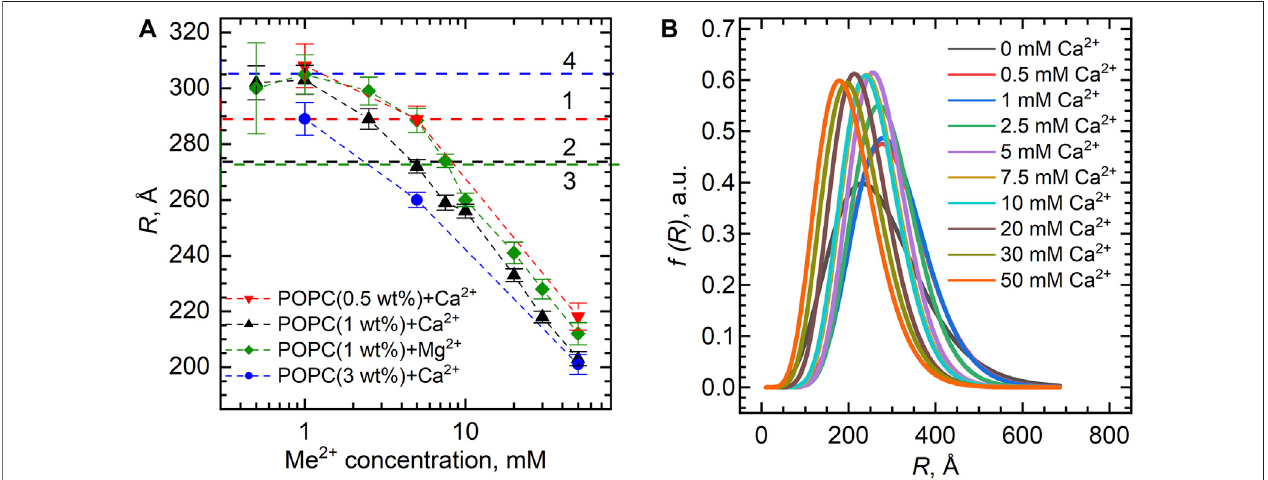
FIGURE 4 | (A) Inner vesicle radii R extracted from the SANS experiments for the POPC bilayers (lipid concentrations of 0.5 wt%, 1.0 wt%, and 3.0 wt%) loaded withvariousCa 2+ andMg 2+ concentrations.Horizontaldashedlinesrepresent R ofPOPCULVswithoutCa 2+ /Mg 2+ obtainedwiththesamemodel,wherenumbers(1 – 4) represent different POPC concentrations in the sample: 0.5 wt% (1), 1 wt% (2 – 3), and 3 wt% (4). (B) Distribution functions of POPC vesicle radii upon Ca 2+ additions extracted from the fi tting of SANS data. The functions are presented in accordance with the Schultz distribution described in the Supplementary Material